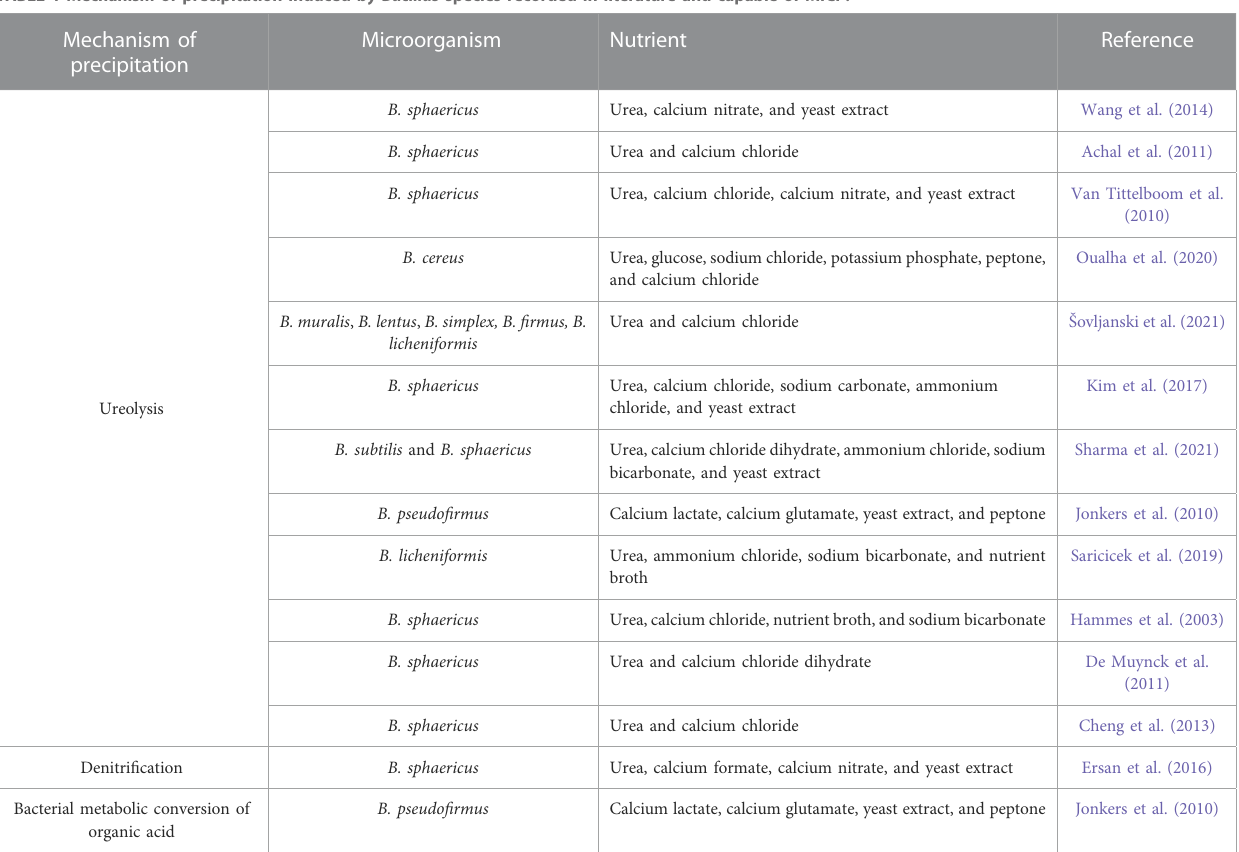
TABLE 1 Mechanism of precipitation induced by Bacillus species recorded in literature and capable of MICP.